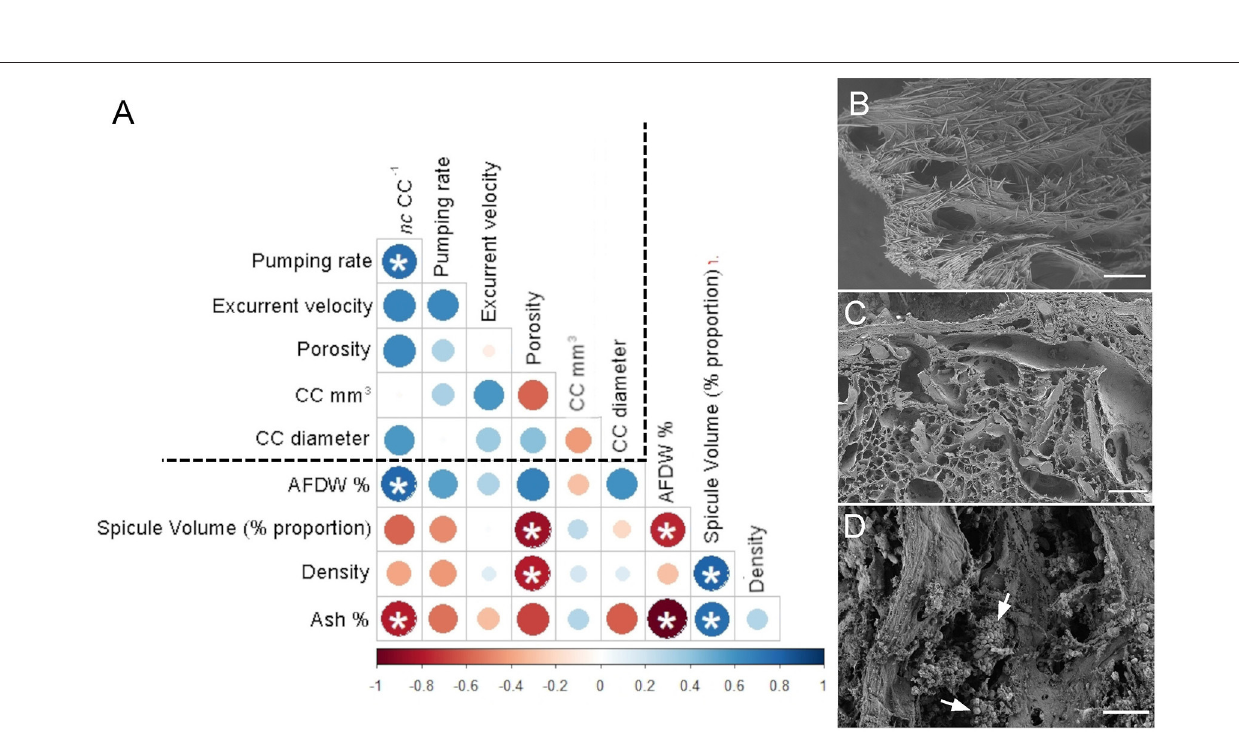
Frontiers in Marine Science |